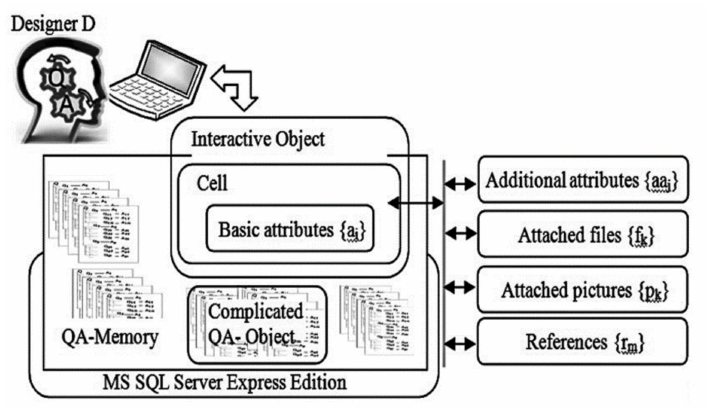
Figure 5. The typical structure of a